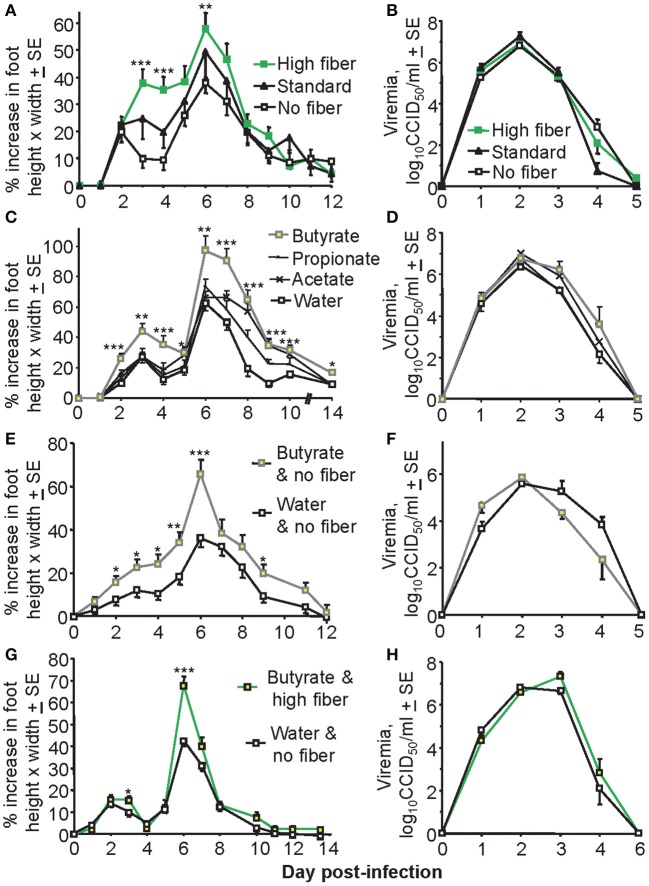
Diet affects foot swelling but not viremia. (A) Mice (C57BL/6J) were fed on either a high fiber diet, a standard diet or a no fiber diet for 3 weeks and were then infected with CHIKV and maintained on the same diet for the duration of the experiment. Foot swelling was measured over time and was higher in the high fiber group compared with the no fiber group; ***p < 0.001, **p = 0.008 (Day 7 approached significance p = 0.051), t-tests; n = 28–30 feet from 14 to 15 mice, with data from two independent experiments shown. (B) Viremia for the mice described in (A). (C) Mice were fed on a standard diet and water was supplemented with 200 mM of the indicated SCFA for the duration of the experiment. Foot swelling was measured over time. Mice drinking butyrate had significantly increased foot swelling than control mice (standard water); ***p < 0.001, **p ≤ 0.003, *p < 0.04, t-tests; n = 12 feet from six mice. (D) Viremia for the mice described in (C). (E) Mice were fed on a no fiber diet and the drinking water was supplemented with butyrate, or were fed a no fiber diet and supplied water for the duration of the experiment. After 3 weeks mice were infected with CHIKV and foot swelling measured. Butyrate significantly increased foot swelling; ***p < 0.001, **p = 0.01, *p < 0.04, t-tests; n = 22–24 feet from 11 to 12 mice, with data from two independent experiments shown. (F) Viremia for the mice treated as described in (E); n = 6 mice, one experiment. (G) Mice were fed on a high fiber diet and the drinking water was supplemented with butyrate, or mice were fed on a no fiber diet and supplied unsupplemented water. After 3 weeks mice were infected with CHIKV and foot swelling measured. Butyrate/high fiber showed significantly increased foot swelling; ***p < 0.001, *p < 0.04, t-tests; n = 24 feet from 12 mice, with data from two independent experiments shown. (H) Viremia for mice treated as described in (G); n = 6 mice, one experiment.